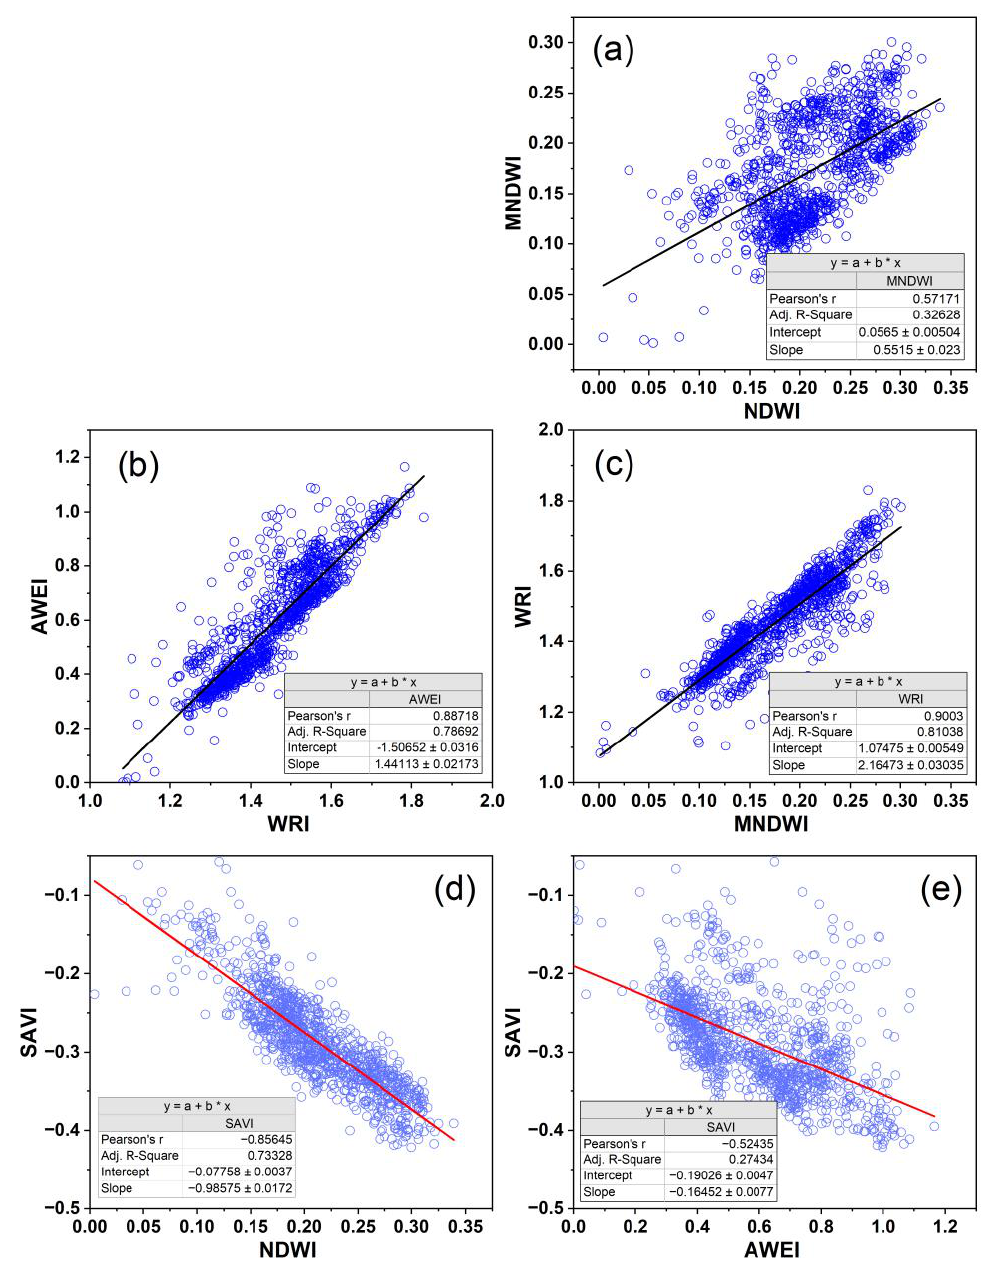
Figure 9. Correlation between water indices: ( a ) NDWI and MNDWI, ( b ) WRI and AWEI, ( c ) MNDWI and WRI, ( d ) NDWI and SAVI, and ( e ) AWEI and SAVI.